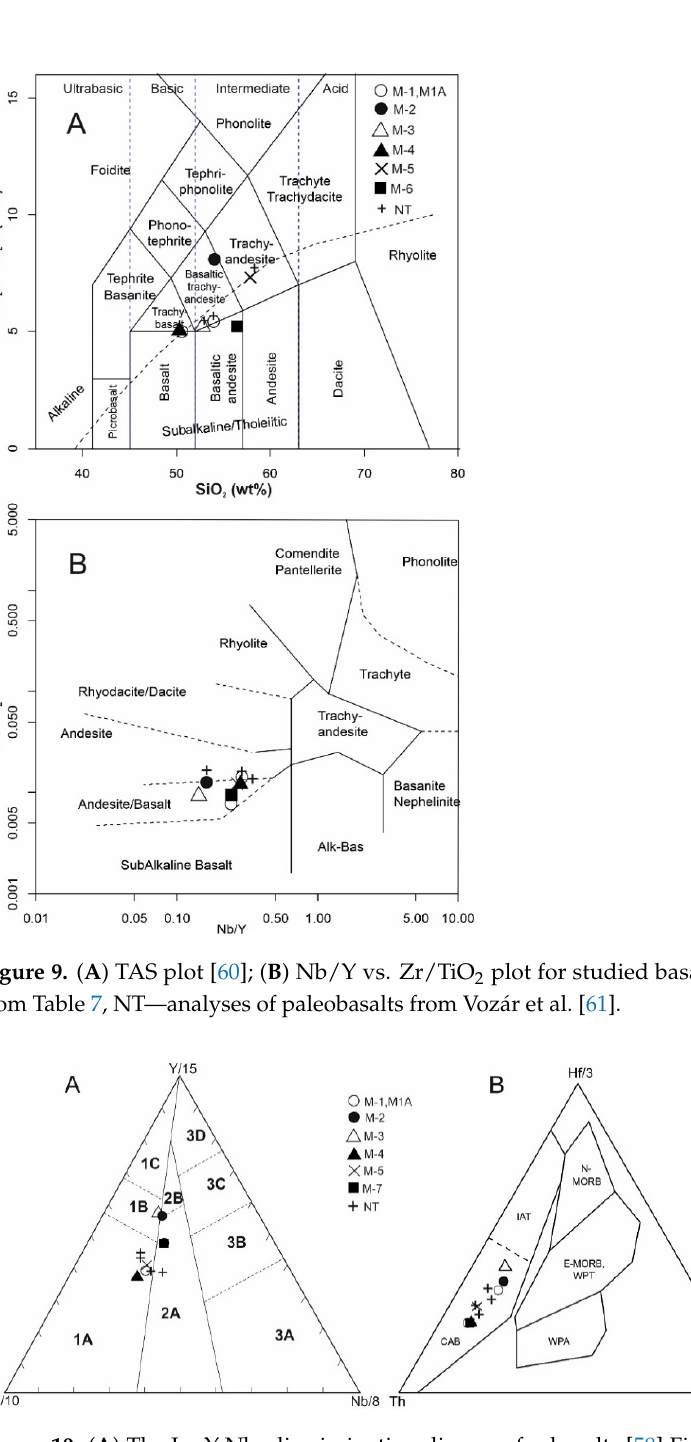
Figure 11. ( A ) REE concentration normalized to the chondrite composition [59]; ( B ) Trace element concentrations normal- ized to the composition of the primitive mantle [62]. Sample M-1—M7 from Table 7. The Sr, Nd, and Pb isotopic compositions were determined in five samples (Table 8, whole rocks) and together with the three previously published results [61] the whole set is represented by eight samples. Two samples from the diorite dykes and three samples from the first and second eruption phases were analysed. The Nd-Sr isotope signature of the studied basalts are scattered around the value of 143 Nd/ 144 Nd for CHUR, where 143 Nd 144 Nd ratios are relatively stable and 87 Sr/ 86 Sr values are relatively varied. (Figure 12). Some of the points lie in field IV, and/or its vicinity, indicating a relatively high proportion of crustal contamination in the formation of these basalts. The study of Pb isotopes gives us similar conclusions. The diagram (Figure 13) illustrates the isotopic ratio of 207 Pb/ 204 Pb vs. 206 Pb/ 204 Pb. The basalt analyses lie in the field of EMII, and/or they partially overlap with the Saxo-Thuringian upper crust fields. Compared to the MORB field, they have higher 207 Pb 204 Pb. The EMII field is defined as a mantle source enriched with crustal mate- rials [63,64]. Crustal materials can be incorporated into mantle material in different ways [65,66]. This position indicates a relatively high degree of crustal contamination. This is especially evident from 206 Pb/ 204 Pb isotope ratios, which correspond to values around 19. This Pb isotope ratio is considered to be the most sensitive indicator of crustal contamina- tion.